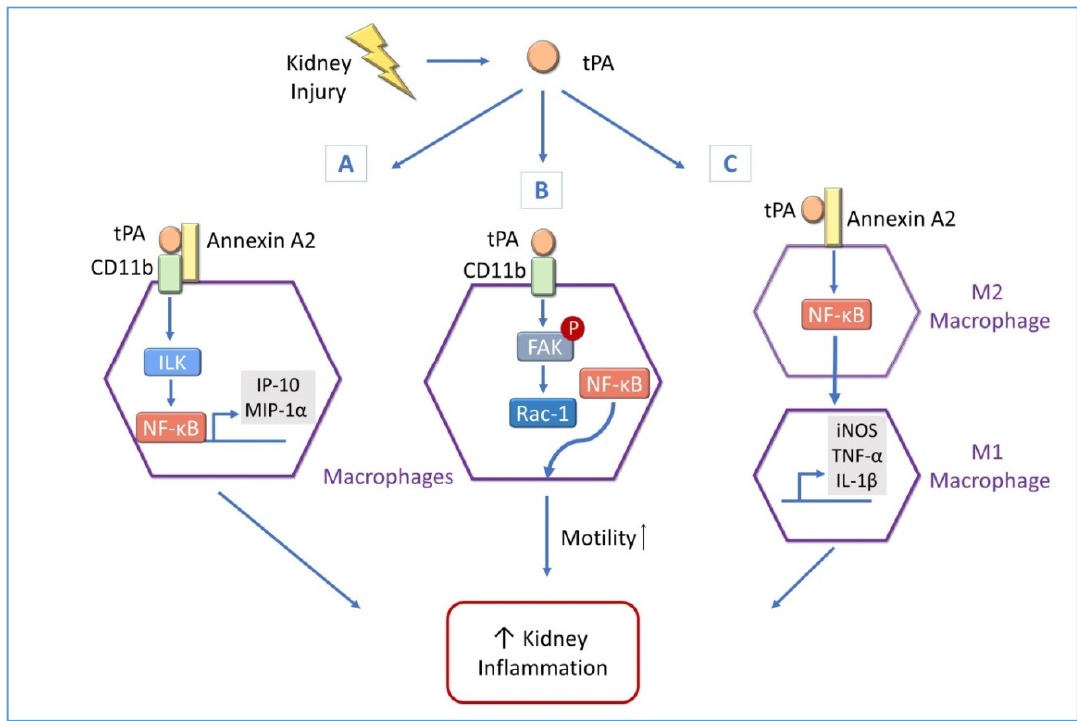
Figure 3. tPA-induced NF- κ B activation in kidney disease. Following kidney injury, there is an increased level of tPA, which in turn mediates NF- κ B activation in macrophages, leading to increased renal inflammation through three signal pathways: ( A ) tPA binds to annexin A2 and promotes aggregation of annexin A2 and CD11b leading to activation of the integrin-linked kinase (ILK) / NF- κ B pathway and expression of NF- κ B-dependent IP-10 and MIP-1 α . ( B ) tPA activates CD11b-dependent focal adhesion kinase (FAK) and the ras-related C3 botulinum toxin substrate 1 (Rac1) pathway. This novel signal cascade, together with tPA-induced NF- κ B signaling, results in increased macrophage motility and ultimately kidney inflammation. ( C ) tPA promotes macrophage M2 to M1 phenotypic change through an annexin A2 and NF- κ B-mediated pathway. Inducible nitric oxide (iNOS), TNF- α , and IL-1 β are typical M1